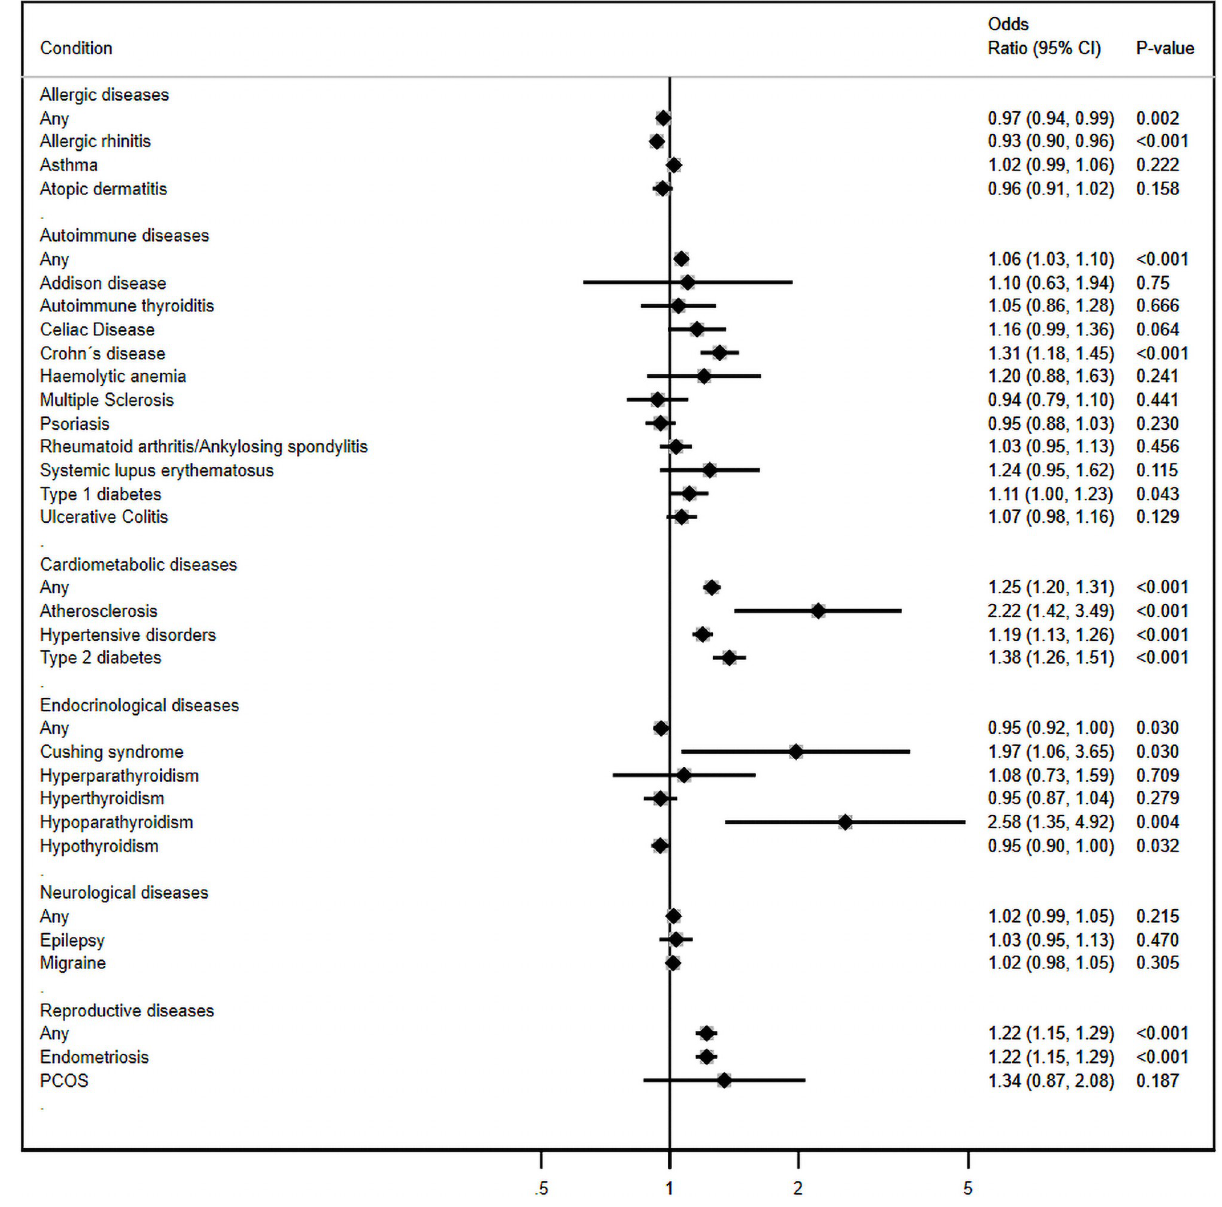
Fig 2. Adjusted odds ratios (ORs) � of miscarriage according to the presence of chronic conditions prior to the start of pregnancy ( n = 593,009). � The ORs are adjusted for the woman’s age at the start of pregnancy as a linear and a squared